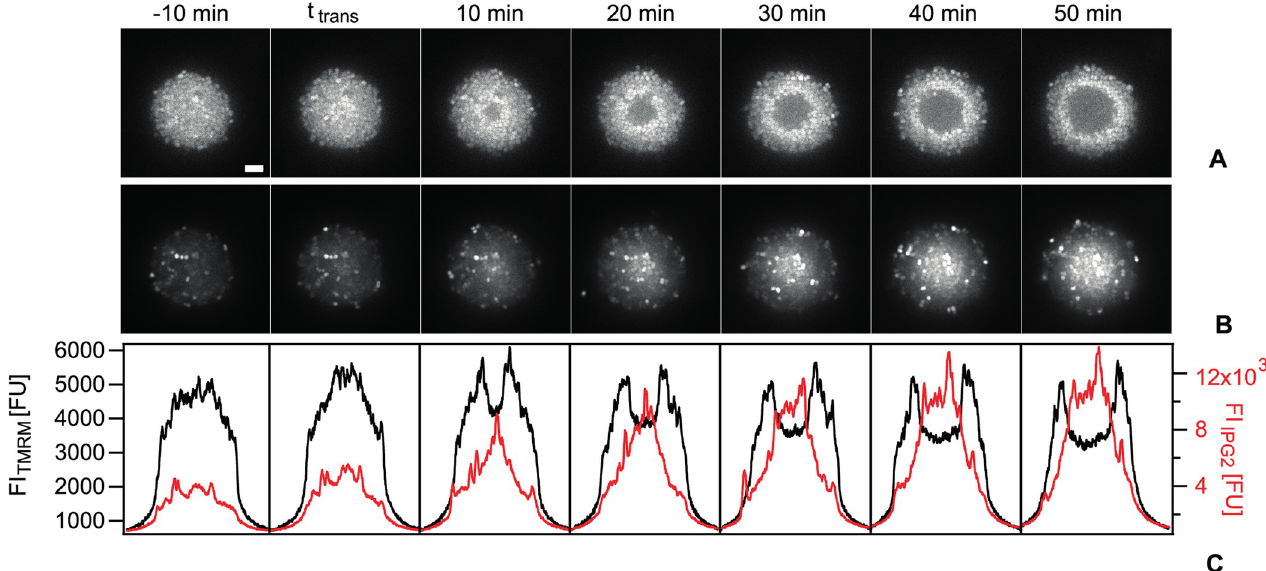
Fig 3. Membrane depolarization correlates with the influx of K + ions. Strain wt � (NG150), static culture. (A) Time lapse of TMRM fluorescence and (B) the K + reporter IPG-2 AM across the equator of a colony. Scale bar: 5 μ m. (C) Intensity profiles along the ROI shown in (A) and (B) (see S1 Data for raw values).